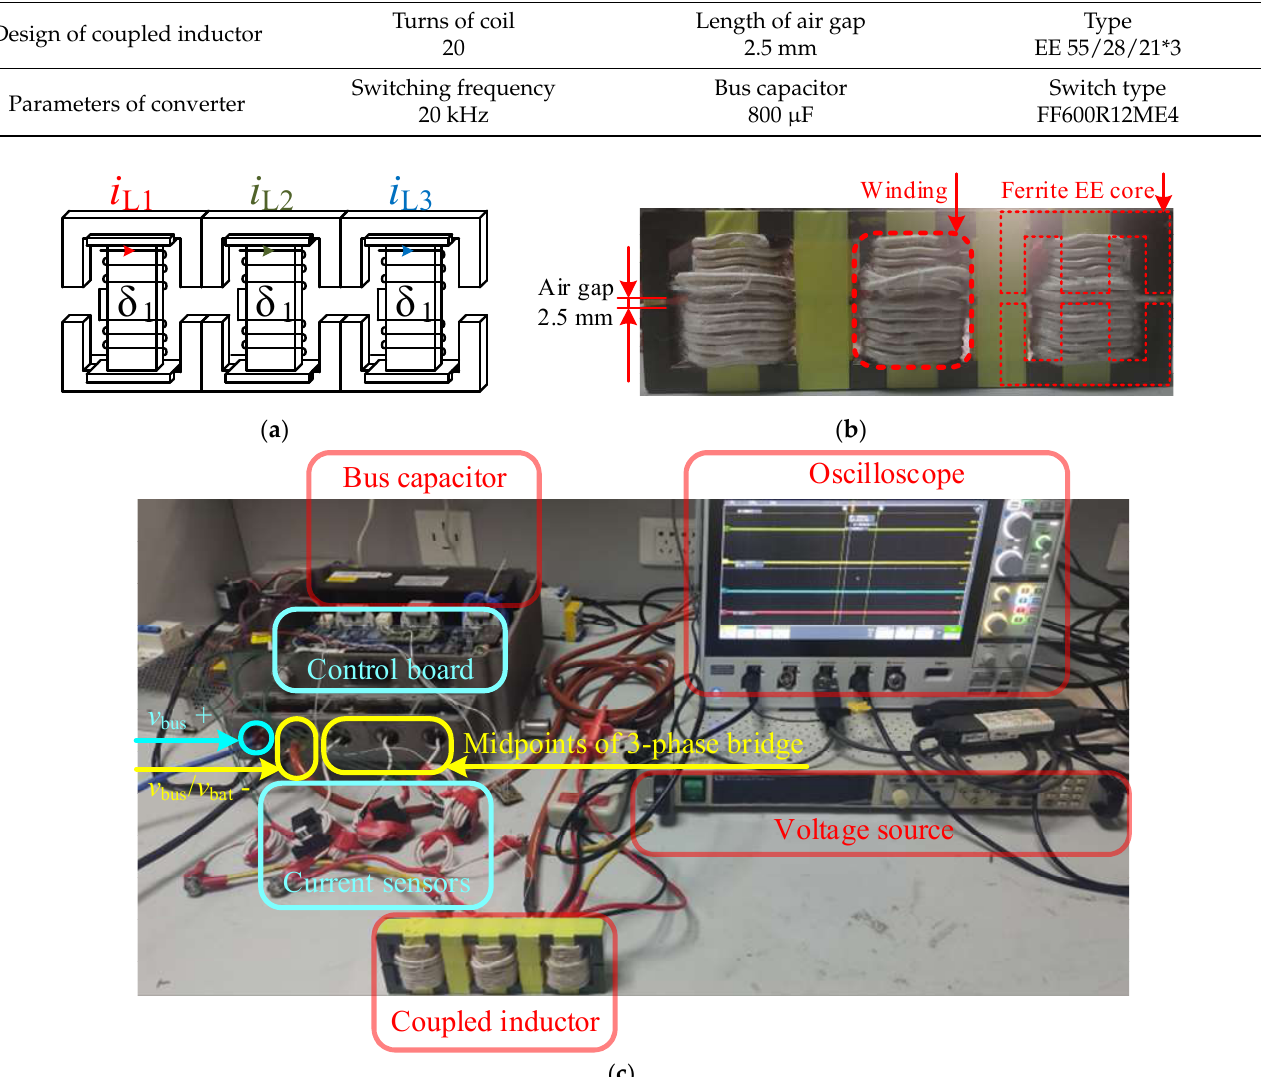
Figure 8. Platform of 3-phase coupled buck–boost converter. ( a ) Structure diagram of 3-phase coupled inductor. ( b ) Coupled inductor used for experiments. ( c ) Platform for verification.